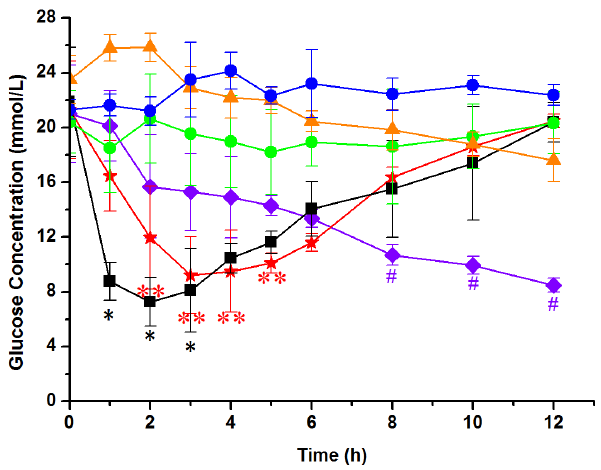
Figure 4. Glucose-lowering effects by exenatide-loaded micro- spheres in db/db mice. Blank microspheres (blue circle); Blank microspheres blending with free exenatide solution via oral delivery (500 m g/kg) (green circle); Subcutaneous injection of free exenatide solution (50 m g/kg) (black square); Oral administration of exenatide- loaded microspheres (cross-linking for 0.5 h, 500 m g/kg) (red star); Oral administration of exenatide-loaded microspheres ( cross-linking for 1 h, 500 m g/kg) (violet rhombus); Oral administration of exenatide-loaded microspheres (cross-linking for 2 h, 500 m g/kg) (orange triangle). Statistical difference between treated group and untreated group (green circle) was indicated as black asterisk, double red asterisk and violet hash under the error bars (P , 0.05). Each group consisted of 8 db/ db mice. doi:10.1371/journal.pone.0086064.g004 3614 6 183 pg h/ml. Even though the maximum plasma exenatide concentration of the group orally treated with exenatide-loaded microspheres by cross-linking for 0.5 h appeared at 4 h after the treatment, this group behaved similarly to subcutaneous injection in terms of AUC value (3667 6 19 pg h/ml). The relative